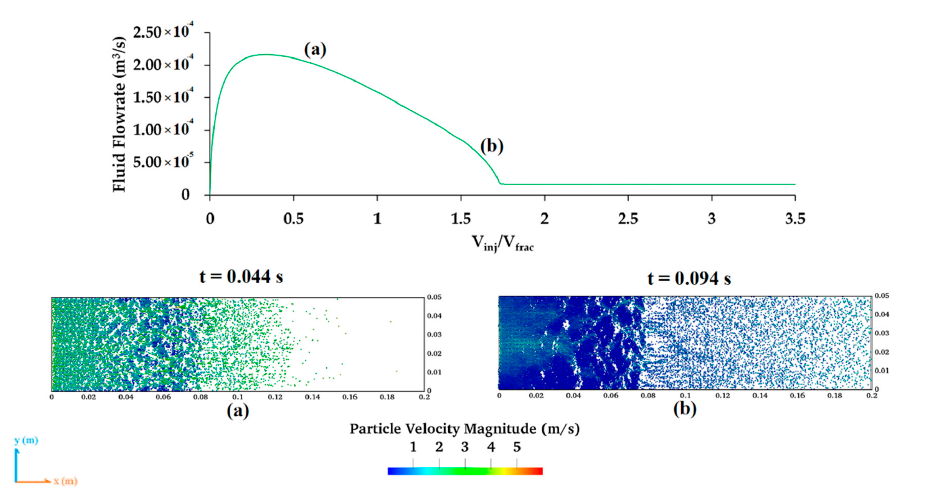
Figure 3. Fracture sealing and its graphical representation. ( a ) Initial packing of few particles. ( b ) A complete seal by LCM particles.